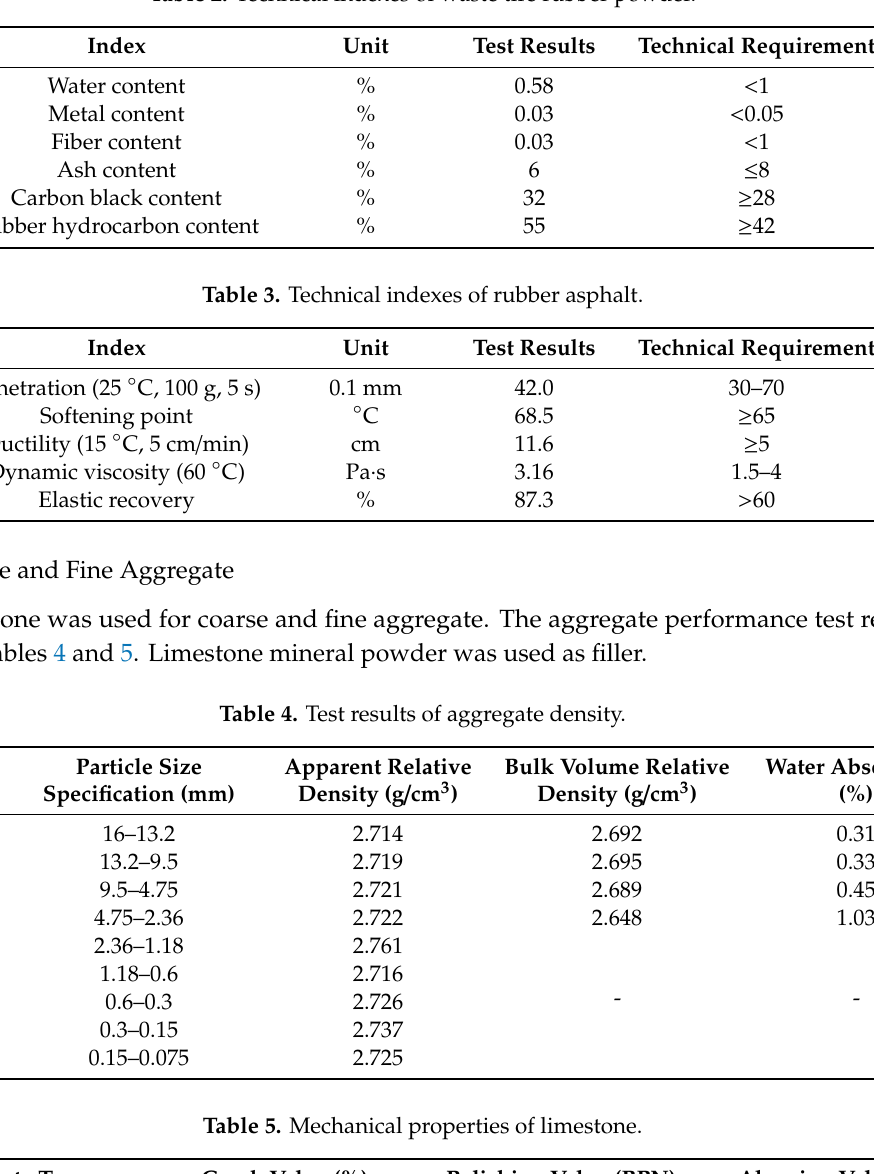
Table 2. Technical indexes of waste tire rubber powder.